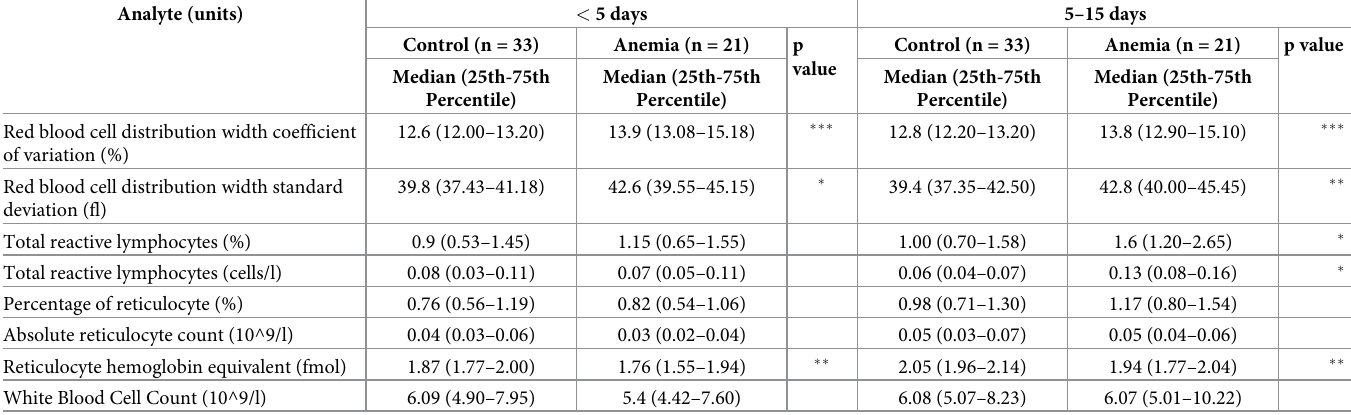
(Fig 1B). Similarly, a higher N/L ratio was observed in patients in the severe group (Group 2) com- pared to patients with moderate disease (Group 1) (Fig 1A).